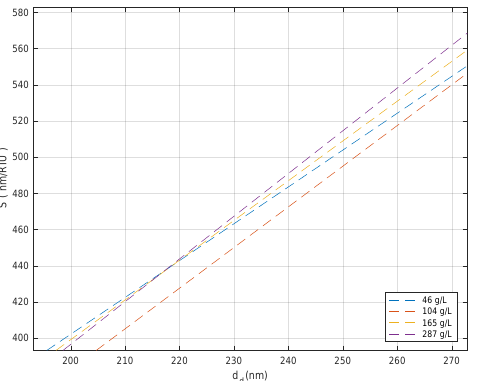
Figure 6. Variation of sensitivity with the defect layer thickness for different hemoglobin